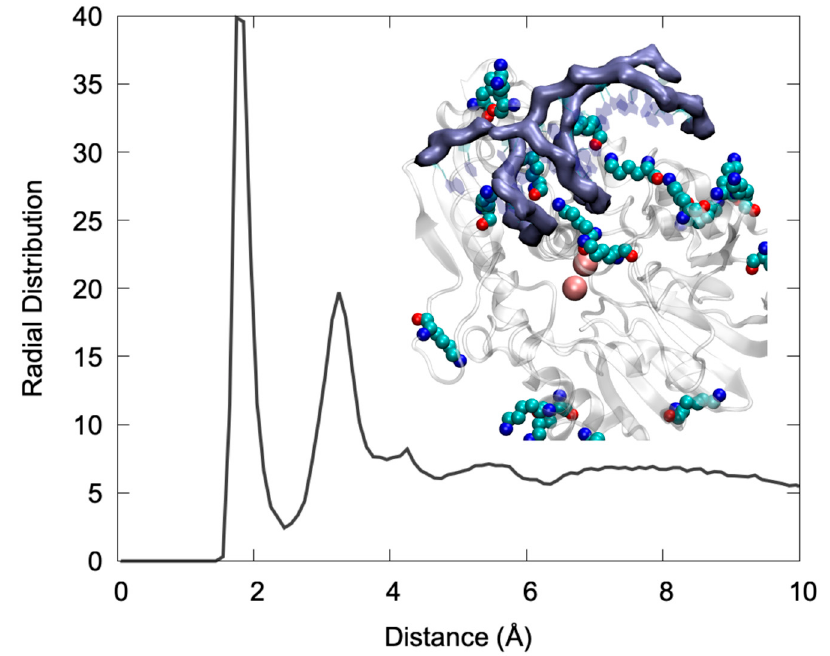
Figure 2. Radial distribution function between the negative O1P and O2P atoms of the DNA backbone and the HZ hydrogen of the LYS ammonium group. A snapshot showing the interaction of LYS charged moieties (in van der Waals representation) with the DNA backbone (highlighted with the purple surface) also shown in the inlay.